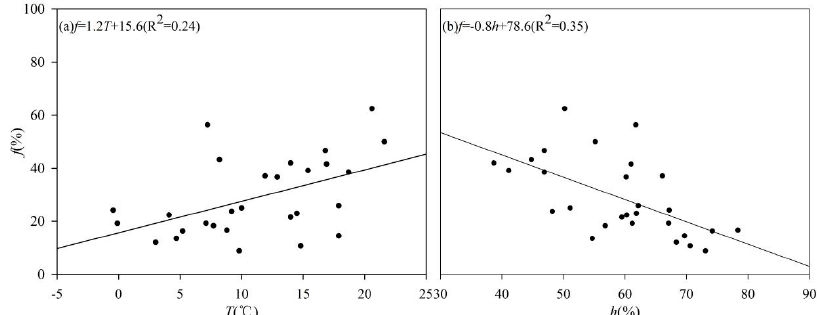
Figure 9. Correlation between temperature, humidity, and evaporation loss (( a ) The relationship between temperature and evaporation loss; ( b ) The relationship between humidity and evaporation loss).